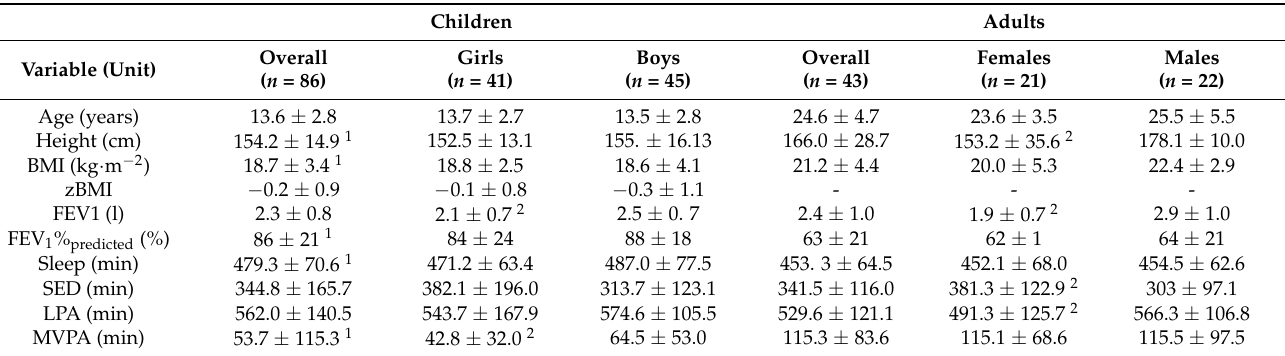
Table 1. Descriptive characteristics, physical activity levels and lung function for children and adults by sex. Children Adults